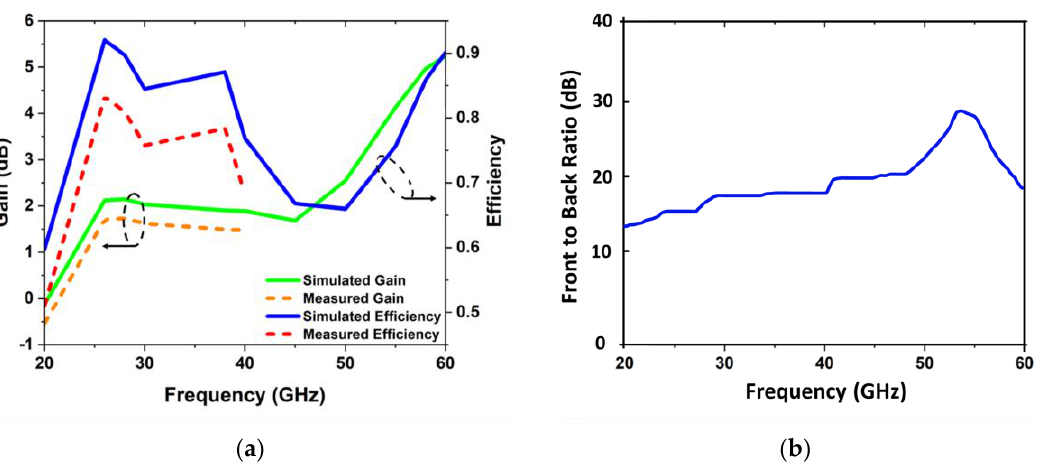
Figure 9. ( a ) Efficiency and gain curves of radiation in relation to different operational frequency bands in free space, ( b ) front-to-back ratio (FBR).